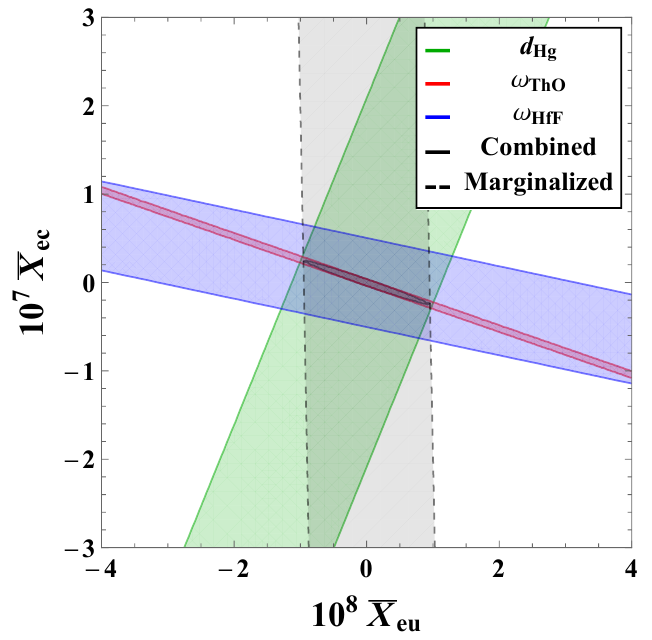
Figure 6 . 90% C.L. constraints from various EDM experiments assuming only the (cid:22) X eu and (cid:22) X ec couplings are present. The dark ellipse is the combined allowed region. The gray dashed band illustrates the allowed region when we also allow for a nonzero (cid:22) X et